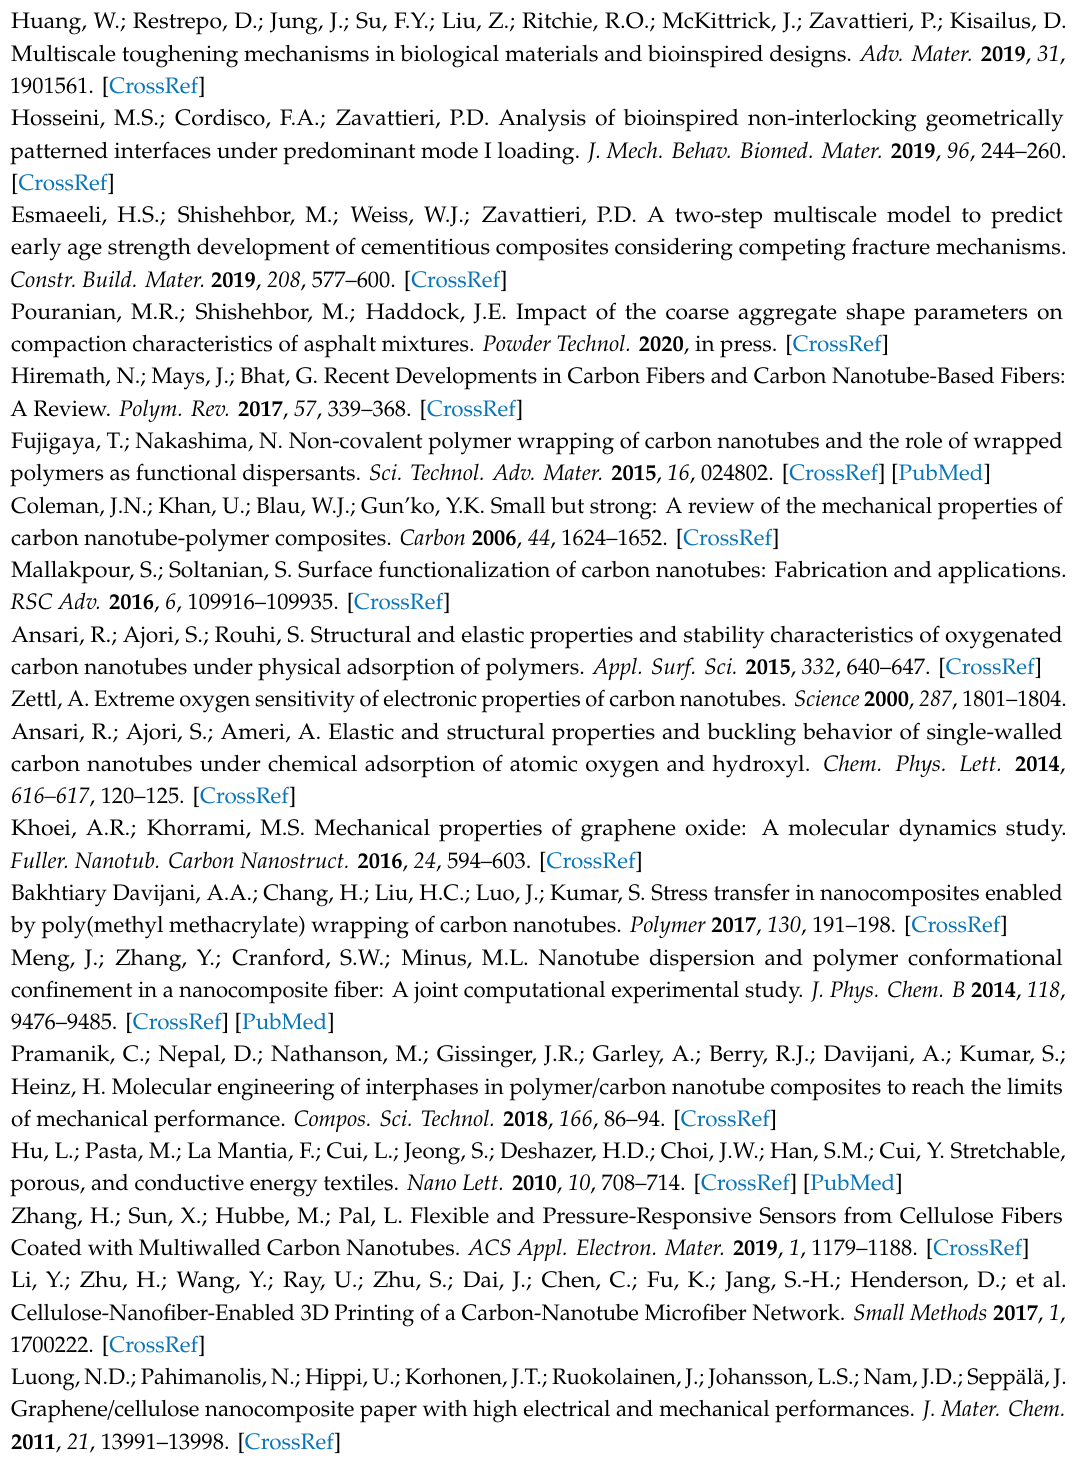
Figure A2. E ff ect of length on the compressive properties of CNT-wrapped cellulose with V f = 0.55. ( a ) Stress-strain curves. ( b ) Variation of strength and Young’s modulus for length. ( c ) Variation of toughness and failure strain for di ff erent lengths. ( d ) Fractured model for di ff erent lengths shows a similar failure